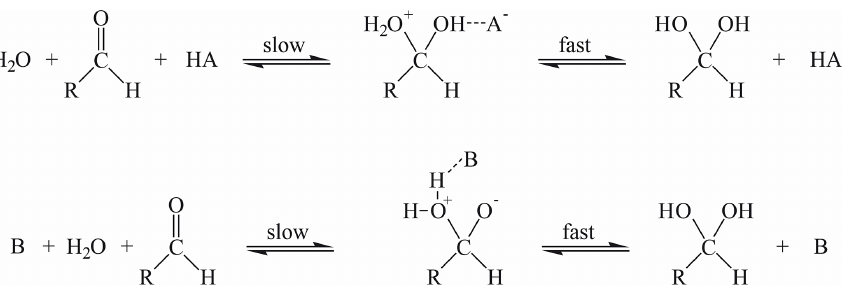
Figure 9. General mechanism of the acid- or base-catalyzed (A and B, respectively) formation of diols resulting from the hydration of the carbonyl group. Table 2. Influence of acidity on the hydration rate of formaldehyde and acetaldehyde in buffered solutions. Acidic species Acid dissociation constant Acid catalytic Base catalytic of the catalyst